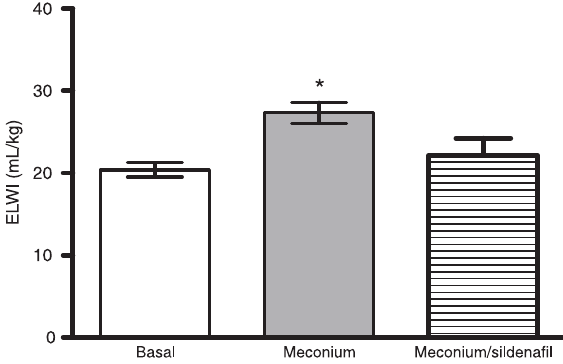
Figure 4. Extravascular lung water indexed (ELWI) under basal conditions, after meconium aspiration and after meconium aspi - ration plus treatment with 2 mg/kg sildenafil. Data are reported as means ± SD. Preservation of the ELWI at low levels is observed when animals with meconium aspiration are treated with sildena - fil, in contrast to animals receiving only meconium aspiration. *P < 0.001 compared to baseline (Student t